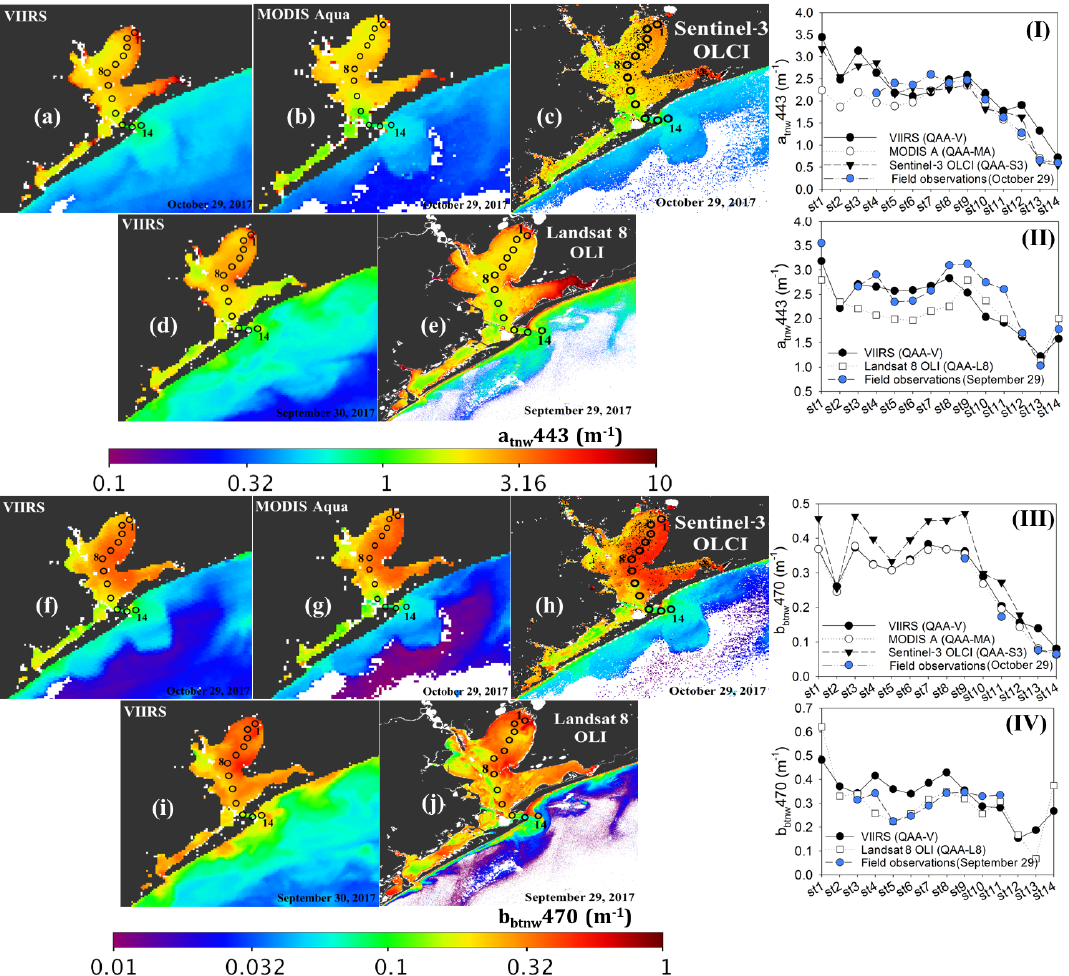
Figure 10. Application of sensor-specific QAA-V tuning to obtain maps of a tnw 443 using (a) VIIRS, (b) MODIS Aqua, and (c) Sentinel-3 OLCI on 29 October 2017 and (d) VIIRS and (e) Landsat 8 OLI on 30 September and 29 September 2017, respectively. The validation of these maps with the field observations along the transect (St. 1 to St. 14) is shown in (I) for Fig. 8a–c and in (II) for Fig. 8d and e. The maps of b btnw 470 were obtained similarly for (f) VIIRS (29 October 2017), (g) MODIS Aqua, (h) Sentinel-3 OLCI, (i) VIIRS (30 September 2017), and (j) Landsat 8 OLI (29 September 2017) with their validation results in (III) and (IV) . Parameter values beyond the upper limit of tuned QAA ( ρ > 0.65) are shown masked in